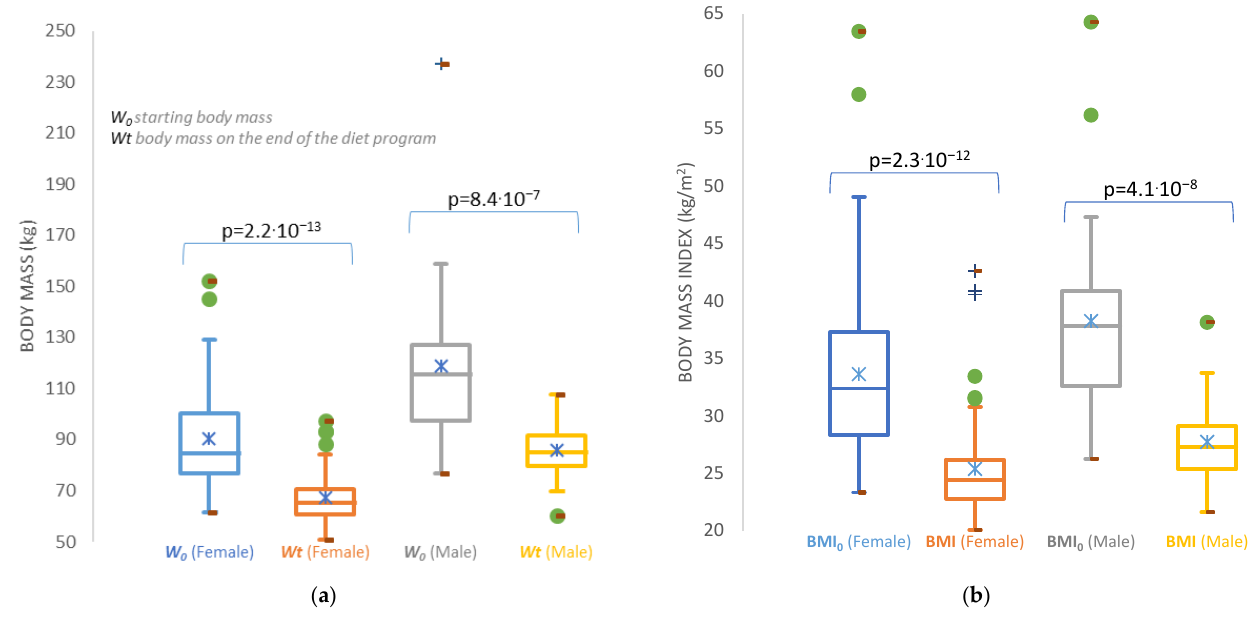
Figure 3. Box-whisker plots of: ( a ) reduced body masses of female and male subjects; ( b ) reduced BMI for female and male subjects enrolled in the ketogenic reduction diet program. Description of what is contained in the second panel.